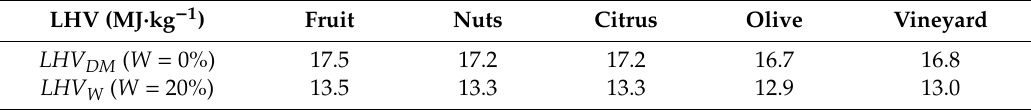
Table 5. Lower heating value (LHV) of the selected pruning wood [52]. Fruit Nuts Citrus Olive